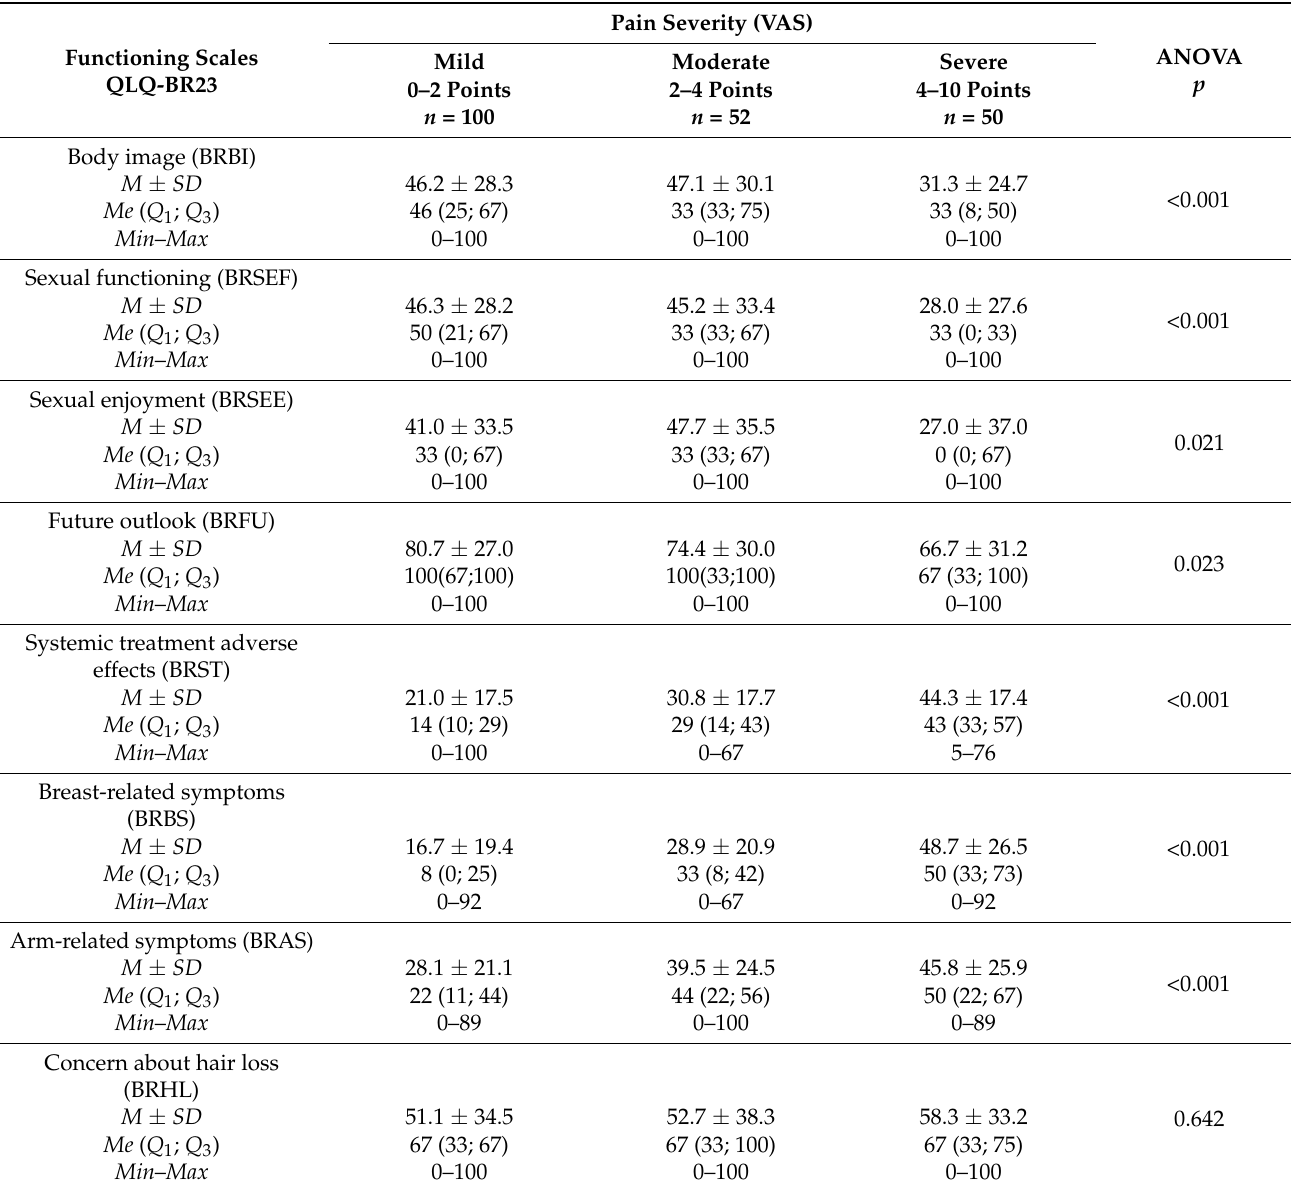
Table 10. Quality of life (EORTC QLQ-BR23 scores) in patients differing in terms of pain severity scores, with analysis of variance